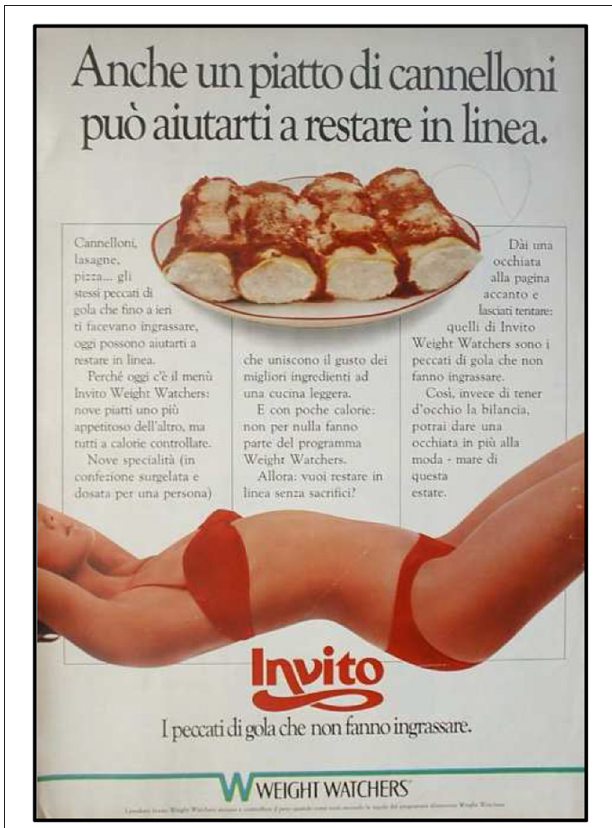
FIGURE 6 | Invito. The sins of gluttony that don’t make you fat.